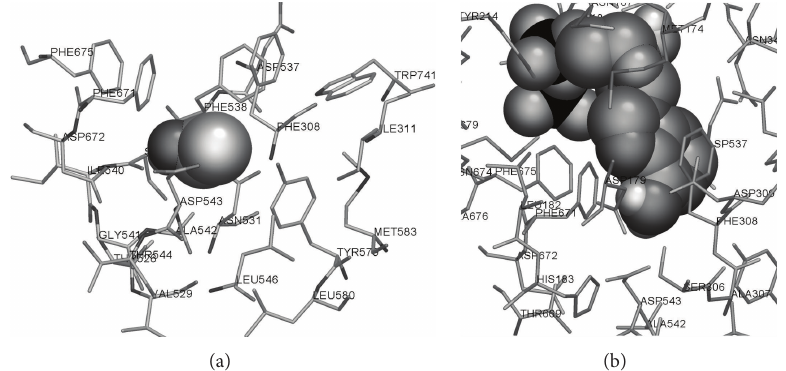
Figure 1: Results of the docking of ethanol (a) and ADP (b) to the model of rat muscle phosphofructokinase. Ligands are shown by spheres, interacting amino acid residues are shown by cylinders, and other amino acid residues of the protein are hidden.